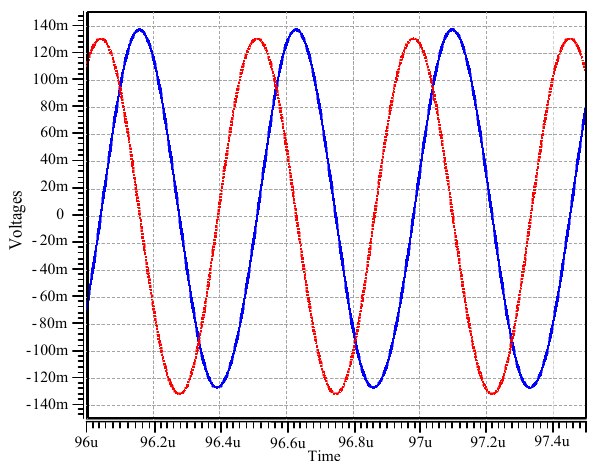
Figure 6. Variation of transconductance with bias current.